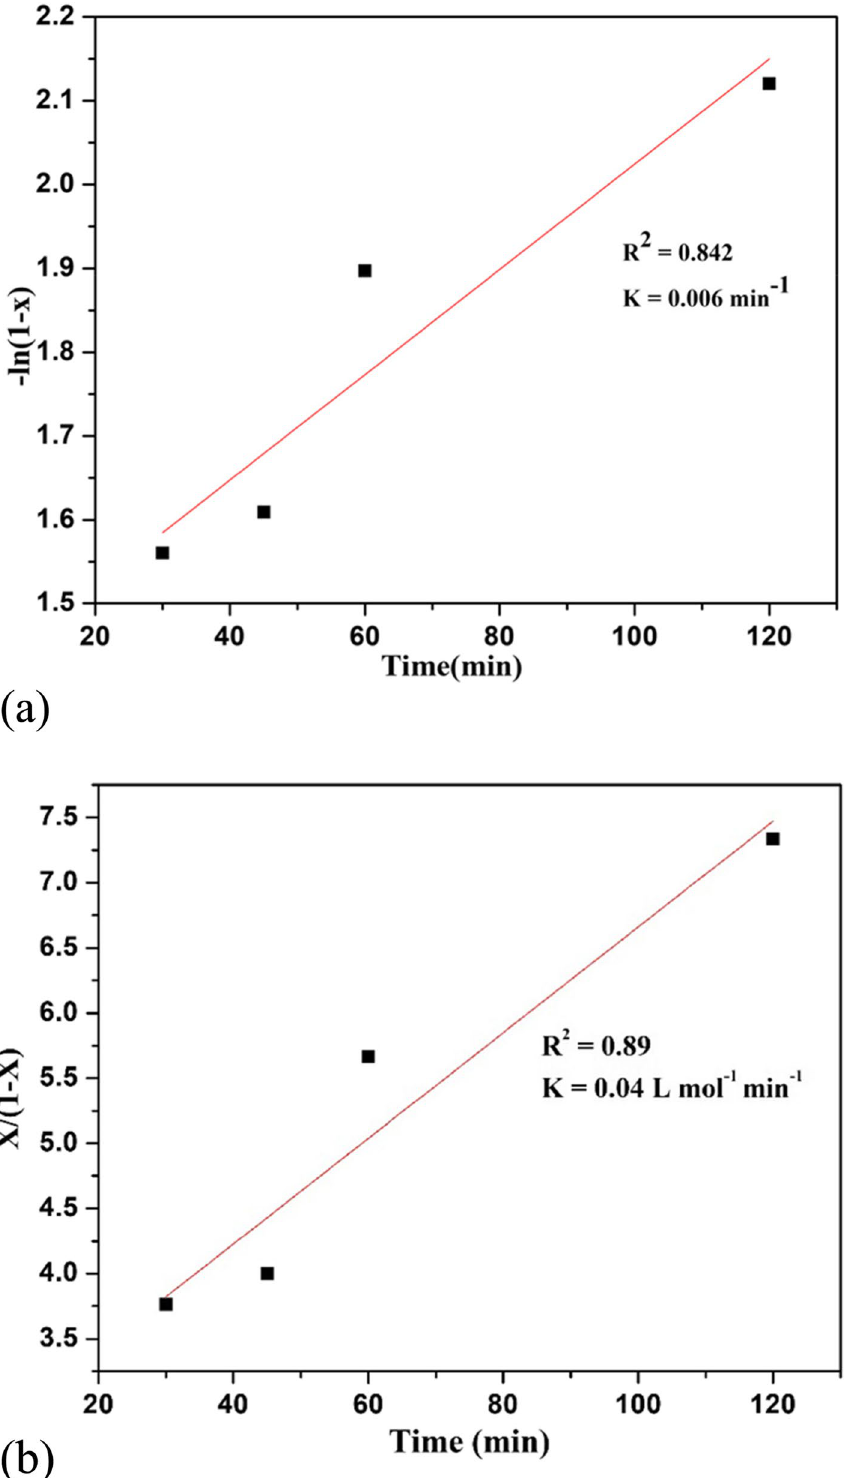
Fig. 14 a Pseudo-first-order rate equation plotted between rate equation plotted between X/(1-X) vs